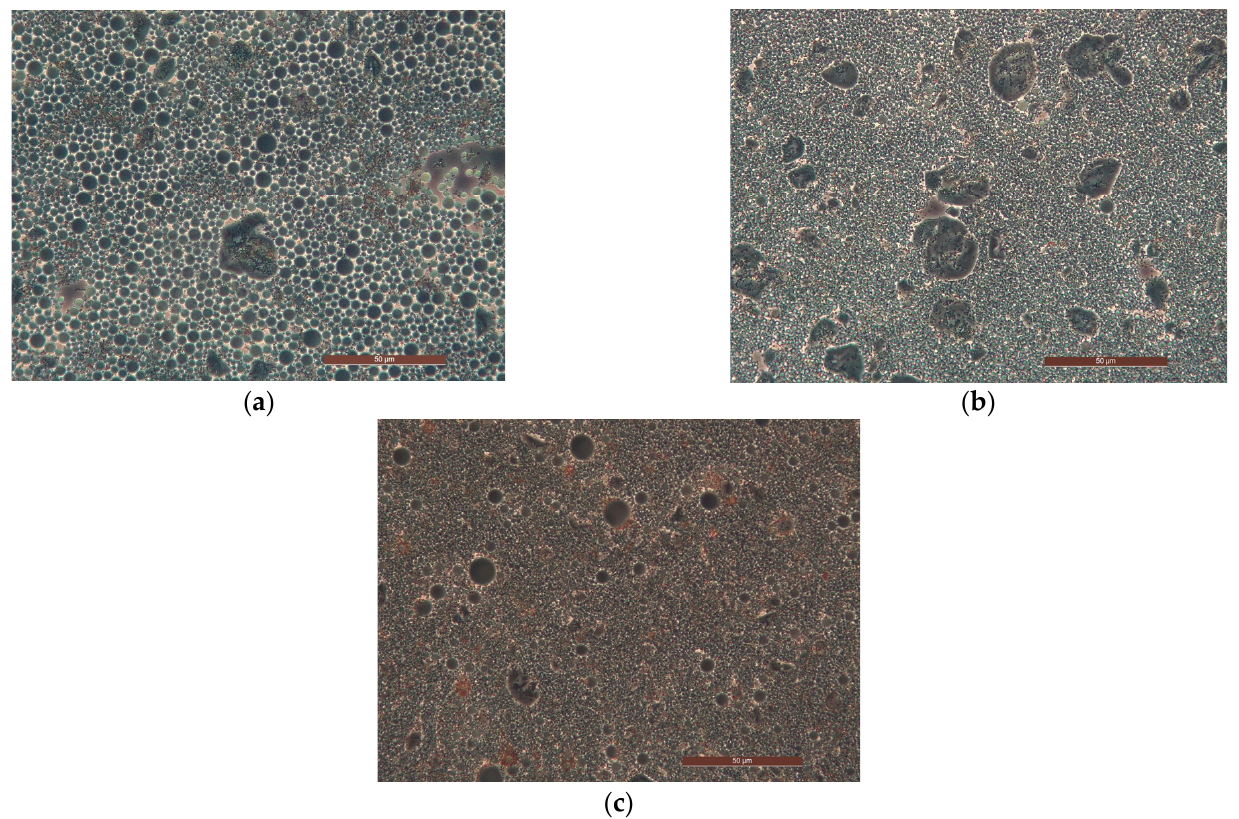
Figure 5. Optical microscopies with 40× magnification of emulsions prepared with A-Z association (ratio 1:1), 40% w/w of oil phase O without ( a ), and with the polysaccharide D at 0.1% w/w ( b ), and D at 0.5 % w/w ( c ).